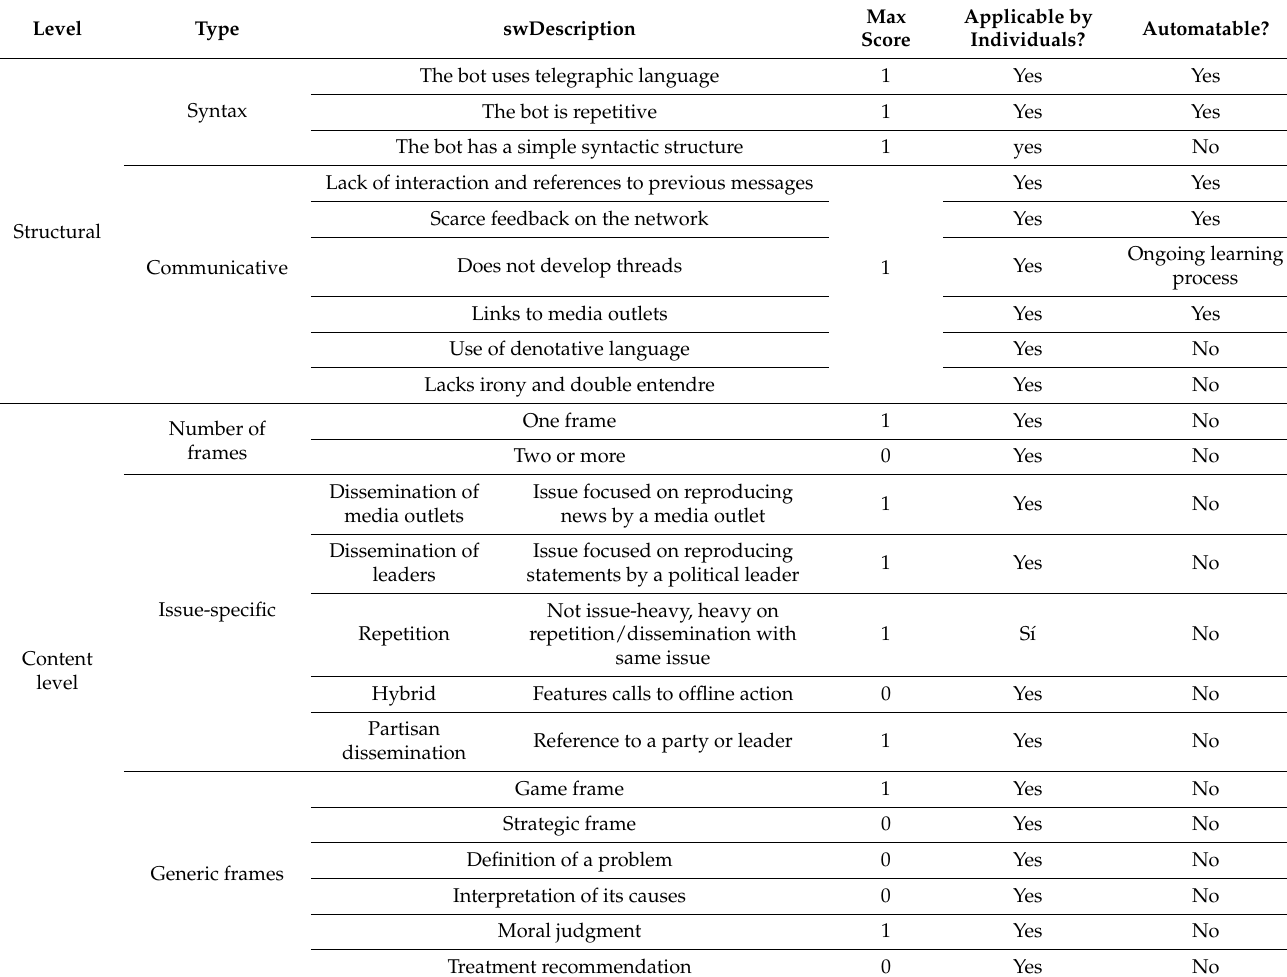
Table 3. Classification instructions for bot